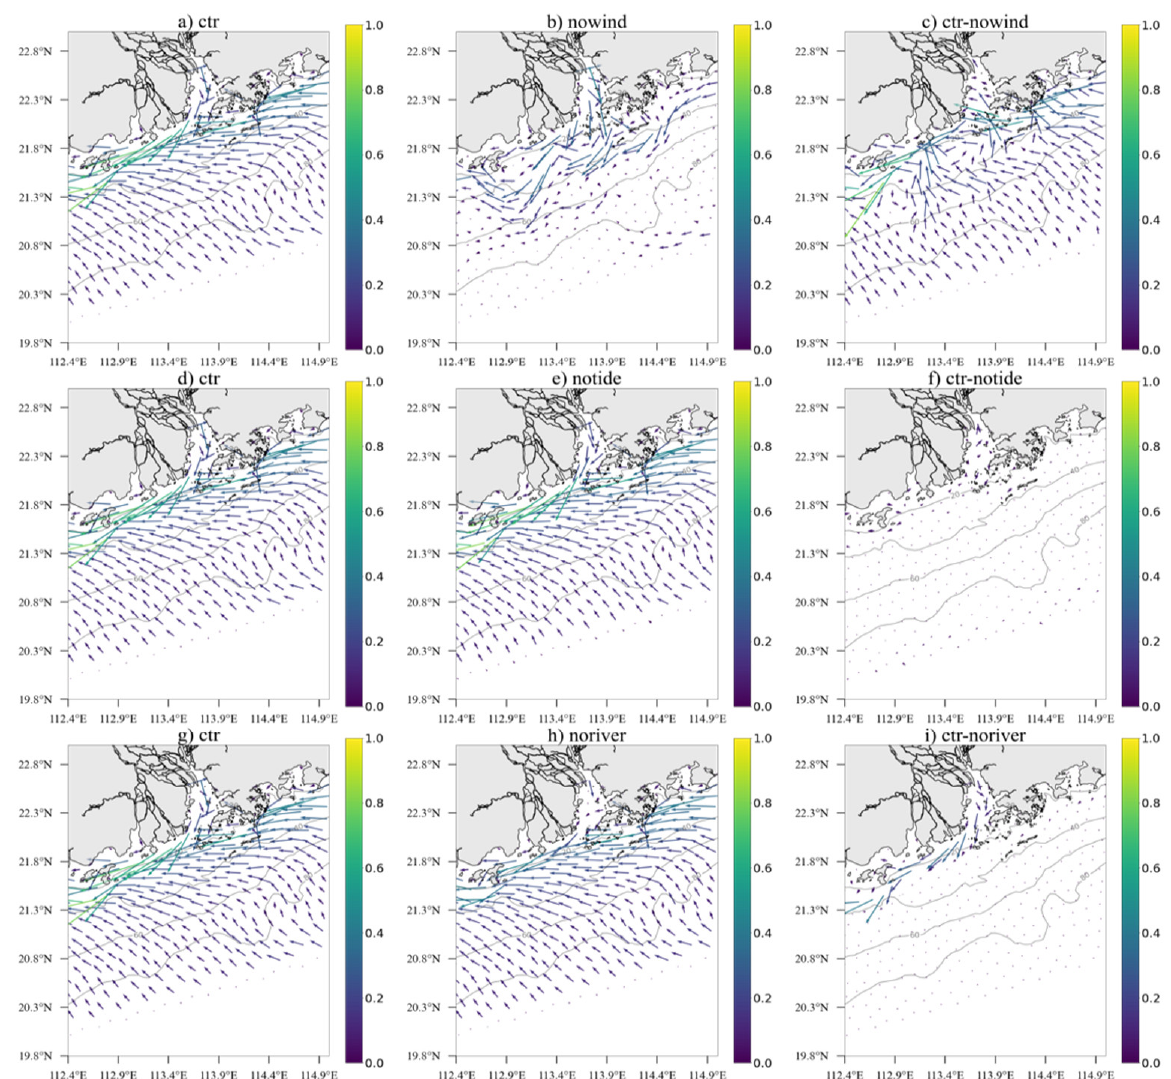
Figure 10. The averaged flow in the control experiments (the left column; ( a , d , g )), sensitivity experiments (the middle column; ( b , e , h ), including tests without wind, tide, or river discharge), and the difference between control and sensitivity experiments (the right column; ( c , f , i )).